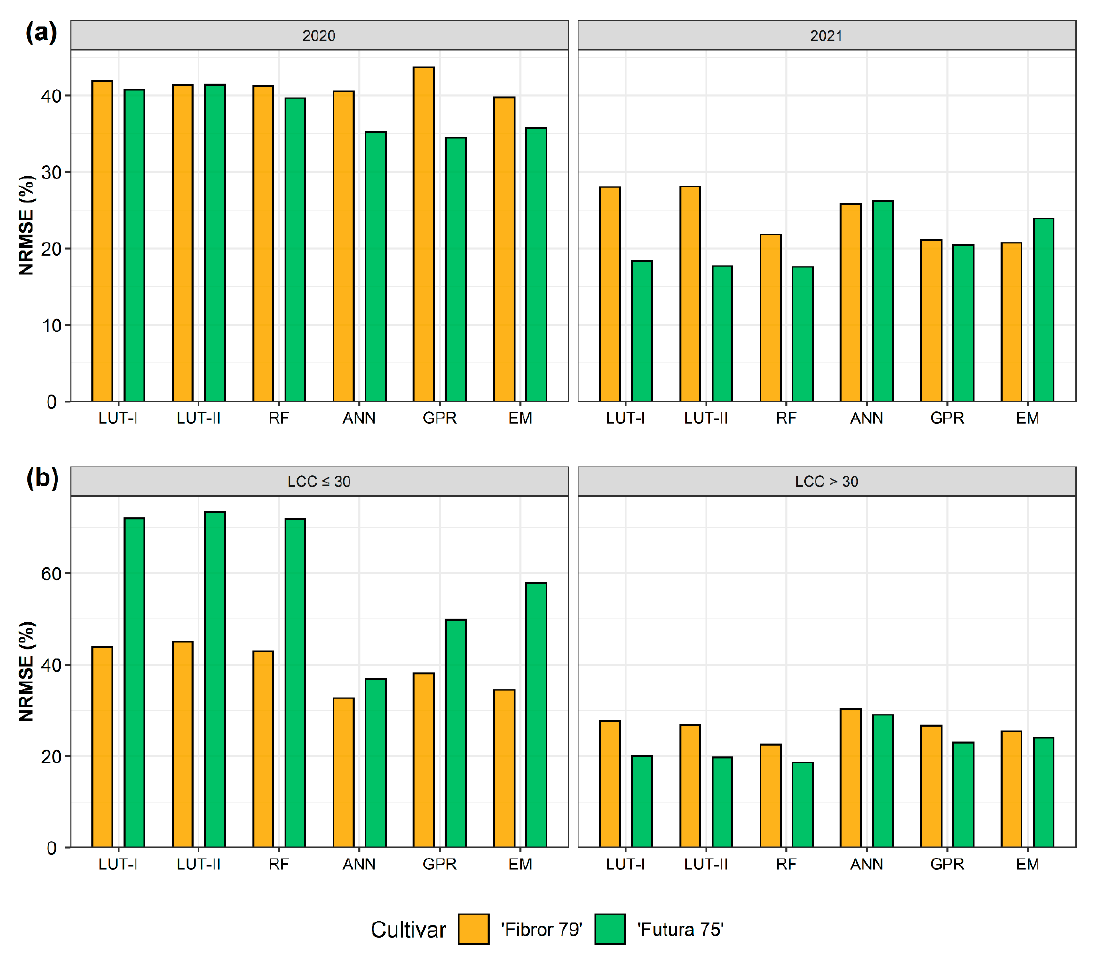
Figure 8. NRMSE values of the inversion methods for LCC estimation according to the different cultivars and ( a ) years and to the different cultivars and ( b ) two LCC intervals (LCC ≤ 30 µg cm − 2 and LCC > 30 µg cm − 2 ).